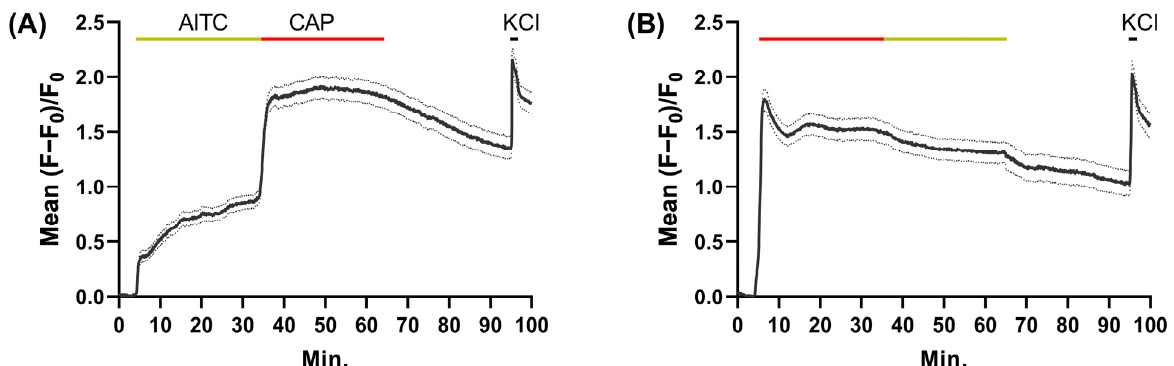
Figure 3. 1 mM AITC induces less intense Ca 2+ signals than 1 µ M CAP in TGNs. After 5 min of baseline recordings, the cells were exposed in sequence for 30 min each to: ( A ) 1 mM AITC followed by 1 µ M CAP, or ( B ) 1 µ M CAP before 1 mM AITC. In both experiments after 30 min washout, 100 mM KCl was also applied for 1 min. Bars above the traces indicate the periods when the neurons were exposed to AITC (yellow), CAP (red bar), and KCl (black). N = 3, n ≥ 100. Solid and dotted black lines indicate the mean increase in fluorescence as a fraction of initial signal intensity ± s.e.m.